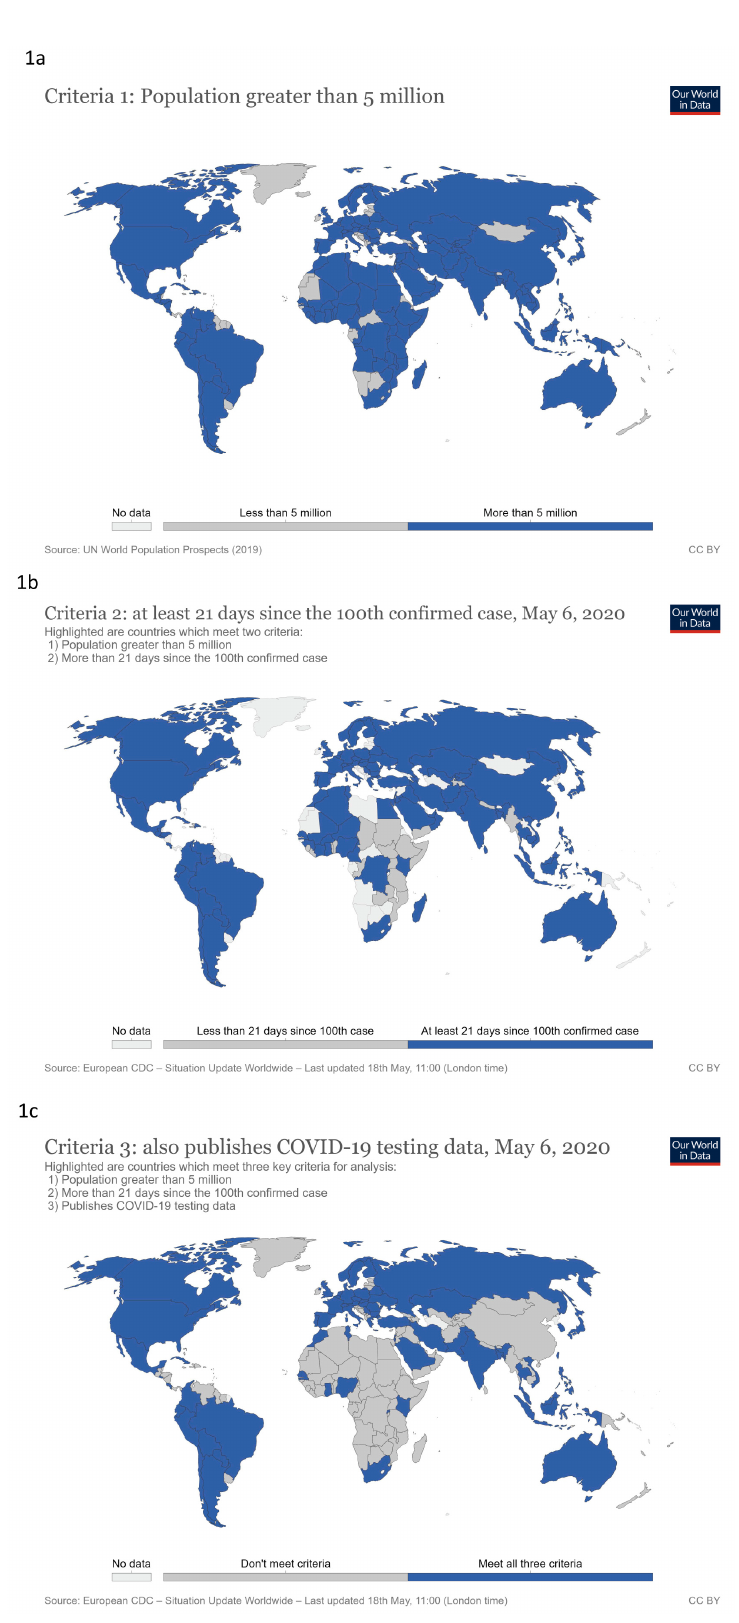
Figure 1. Countries assessed in this study. These world maps show countries with a ) populations over 5 million people, b ) at least 100 confirmed people with COVID-19 21 days prior to assessment and c ) published testing data. Updated graphs can be found here, here and